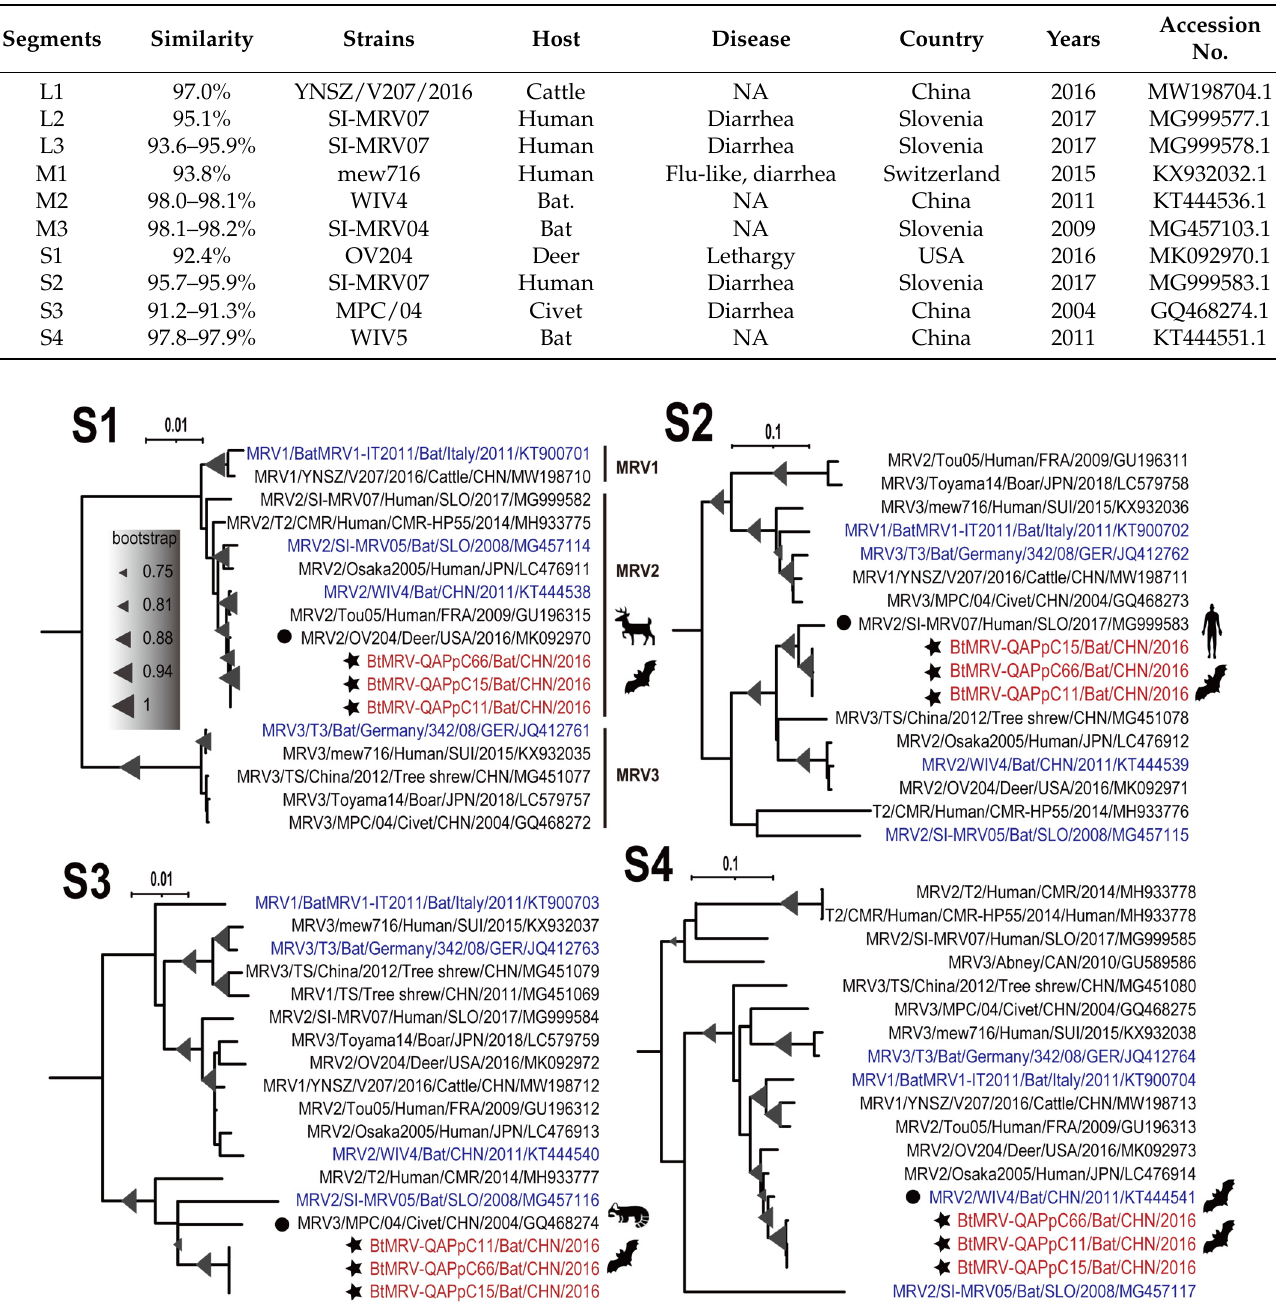
Figure 4. Phylogenetic analyses of the ( S1 – S4 ) segments based on nt sequences. The phylogeny of S1 indicates that the three isolates belong to MRV serotype 2. The phylogenetic reconstruction was implemented using the maximum likelihood method and applied the best-fit model with 1000 bootstrap replicates. Each MRV strain is identified with its serotype, name, host, country, year, and GenBank accession number. Bootstrap value greater than 75 is shown on the node as a triangle with its size indicating the value (shown in panel S1). The three bat MRV isolates in this study are headed with filled stars, and the closest genetic neighbors are indicated with filled circles. The scale bar indicates the genetic distance. The animal cartoons indicate the hosts of the viruses they are next to, and their meanings are shown in Figure 5.